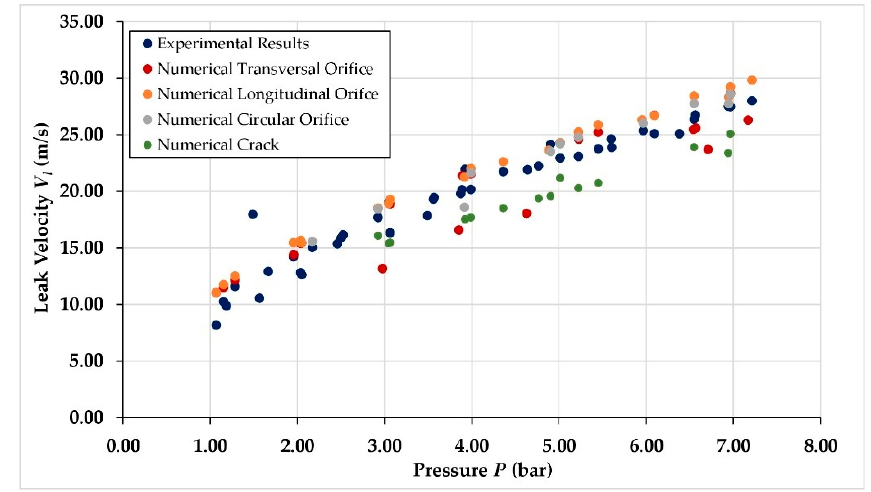
Figure 10. Leak velocity comparison between experimental data and numerical simulations.